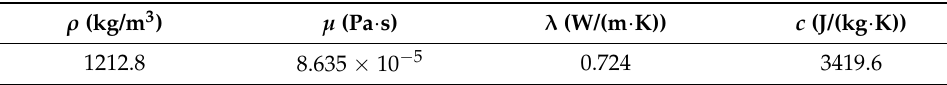
Table 1. Physical properties of 4% CuO nanofluid.